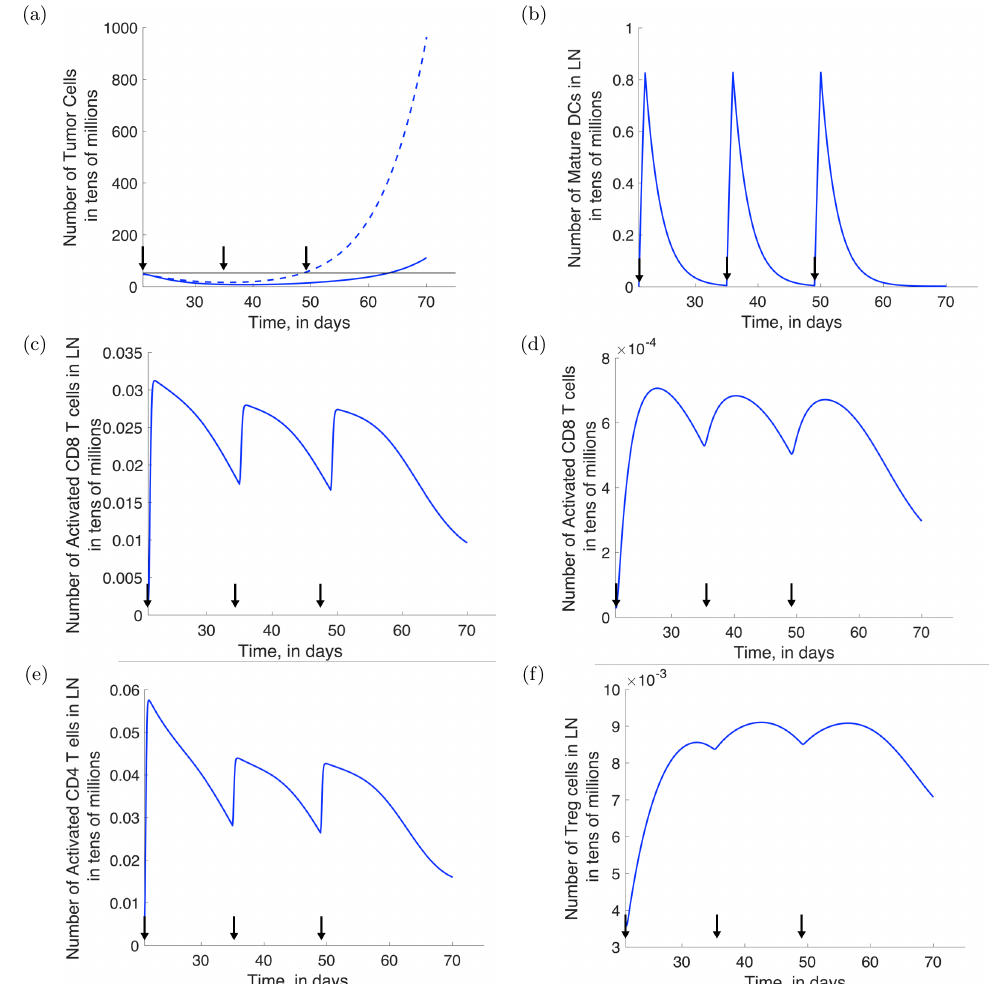
Figure 6. Predicted time courses of cell numbers after concurrent administration of ADT and Provenge, starting on day 21. ( a ) Number of tumor cells ( N + M + D A + D N ) with ADT alone (dashed blue curve) or combination therapy (solid blue curve). The horizontal black line corresponds to the treatment failure threshold (tumor volume of 420 mm 3 ). ( b ) Number of mature DCs in the lymphoid compartment after combination therapy. ( c ) Number of activated CTLs in the lymphoid compartment after combination therapy. ( d ) Number of activated CTLs after combination therapy. ( e ) Number of activated Th cells in the lymphoid compartment after combination therapy. ( f ) Number of Tregs in the lymphoid compartment after combination therapy. Black arrows indicate days on which Provenge was